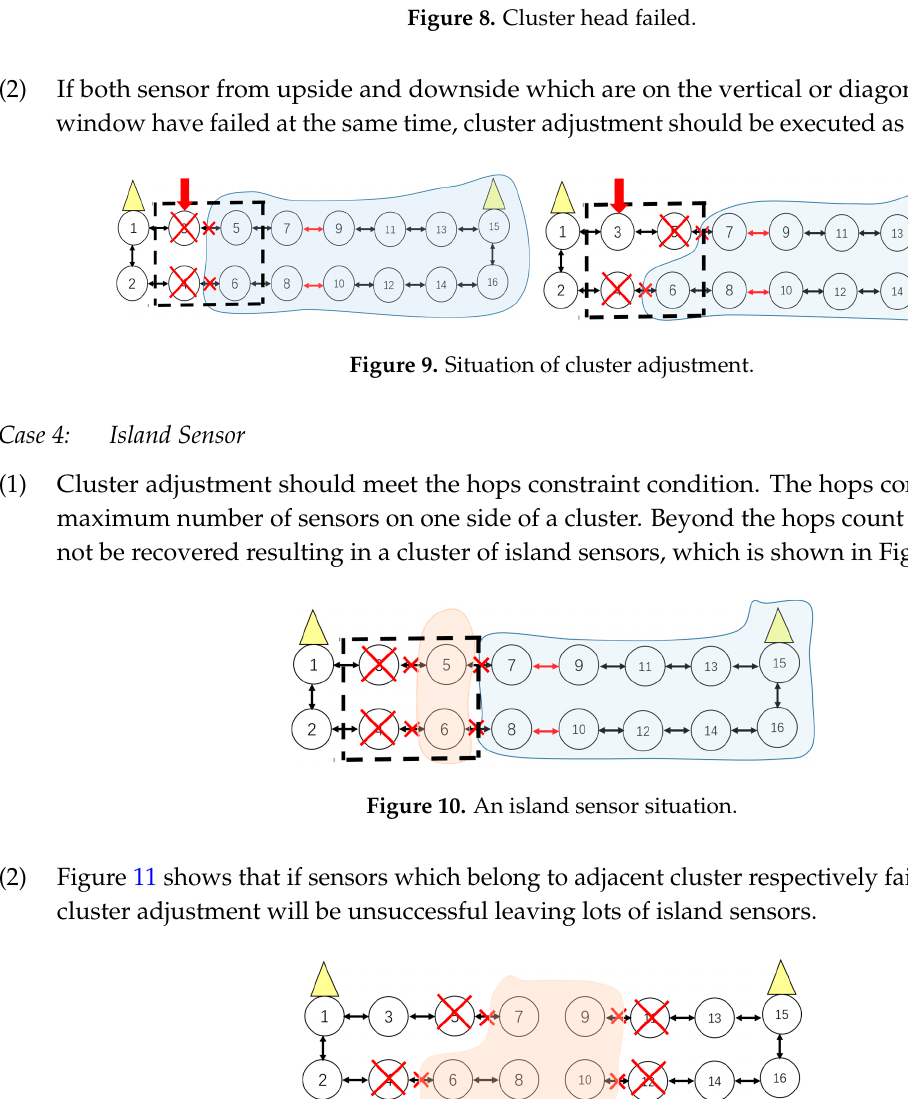
Figure 11. Another island sensor situation.